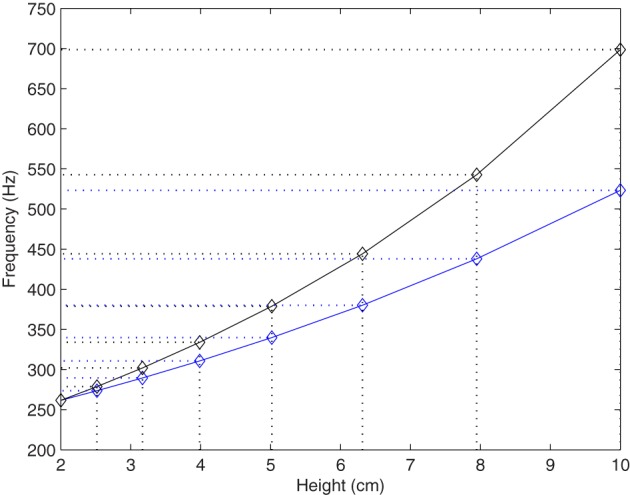
Height to frequency mapping. Bi-modal feedback conditions “pitch 1” (blue line) and “pitch 2” (black line).